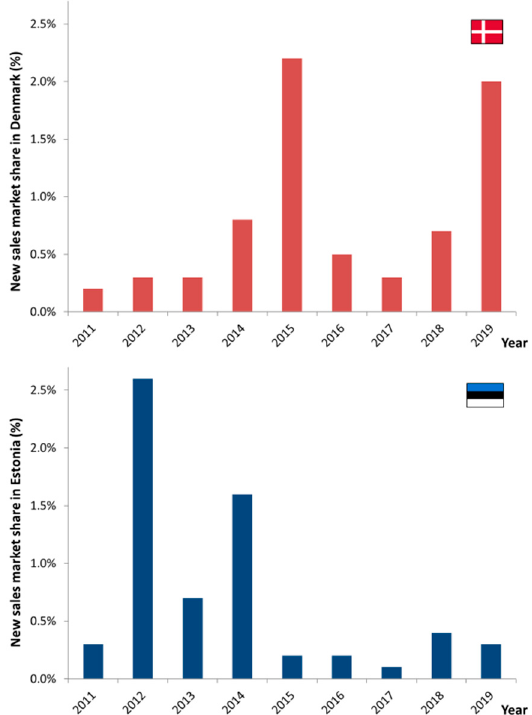
Figure 3. Electric vehicle market shares in Denmark and Estonia from 2011 to 2019. 2019 sales data are January–July. Data from European Alternative Fuels Observatory [7].